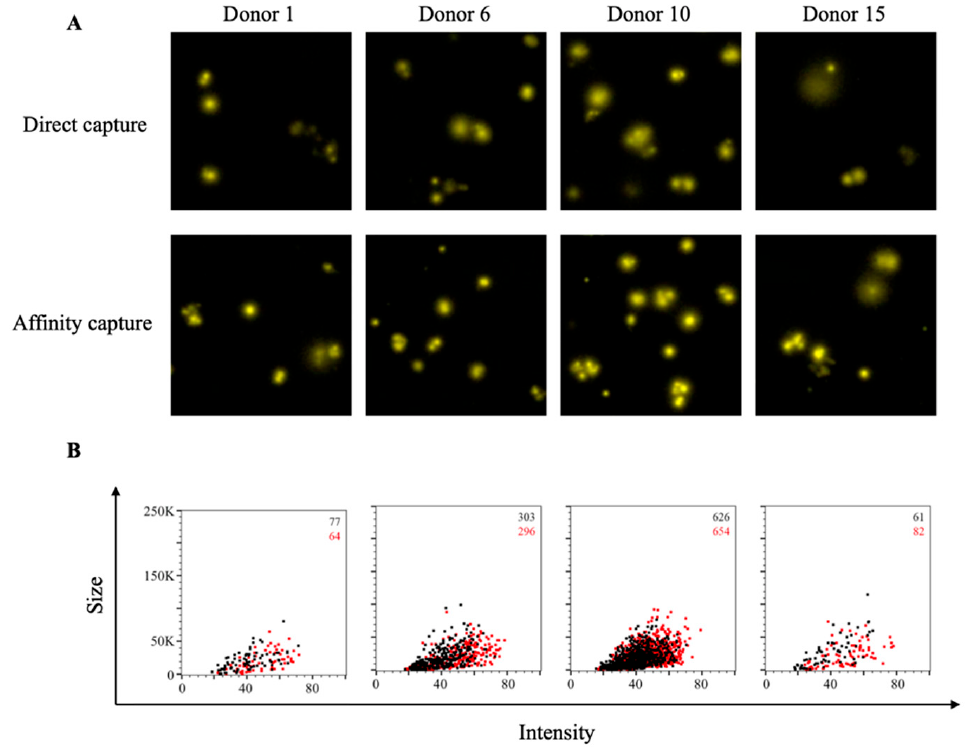
Figure 6. Improved sensitivity of CA/09 rHA-specific ASC through affinity capture of coating antigen. PBMC were stimulated in vitro and evaluated for antibody-secreting (ASC) reactivity against recombinant hemagglutinin protein representing the A/California/04/2009 (CA/09) H1N1 vaccine strain. ( A ) Representative well images depicting antigen-specific IgG + ASC in wells coated directly with 10 µ g/mL of CA/09 rHA or through affinity capture using the genetically encoded hexahistidine (6XHis) tag. Magnification and contrast enhancements were uniformly performed on all images to aid their visualization in publication. ( B ) CA/09 rHA-specific FluoroSpots were merged into FCS files and visualized as bivariate plots. FluoroSpots originating from assay wells in which CA/09 rHA was directly captured on the membrane (black dots) or through affinity capture (red) are shown as overlays. The combined number of FluoroSpots detected in replicate wells for each of the respective donors is indicated in the inset using the same red/black color code.